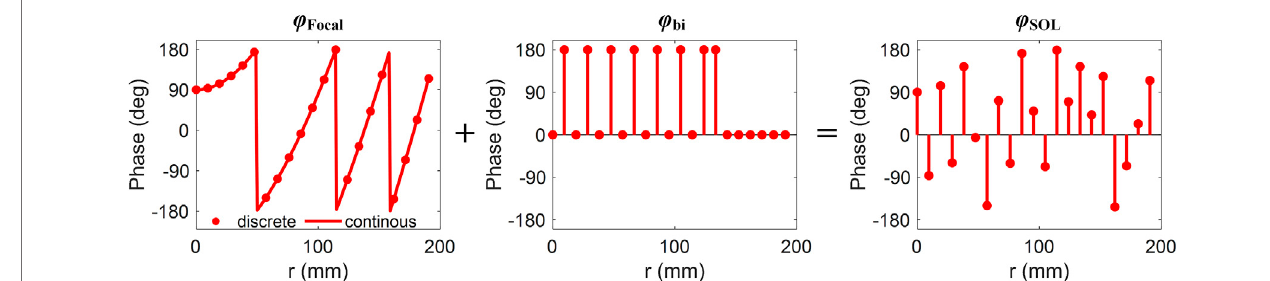
FIGURE 6 | The optimized phase pro fi le of SOL at 11 GHz.